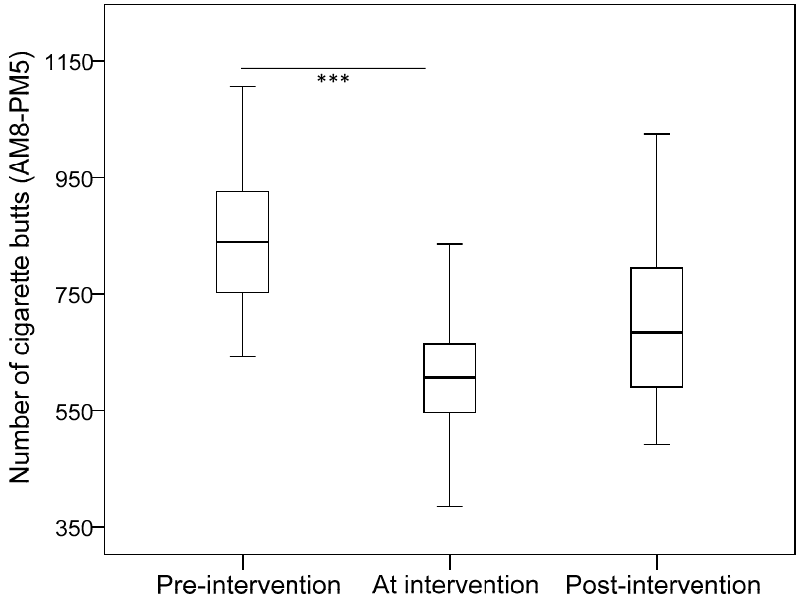
Figure 2. Number of cigarette butts during the whole day among the three phases of the study. *** indicates p < 0.001.